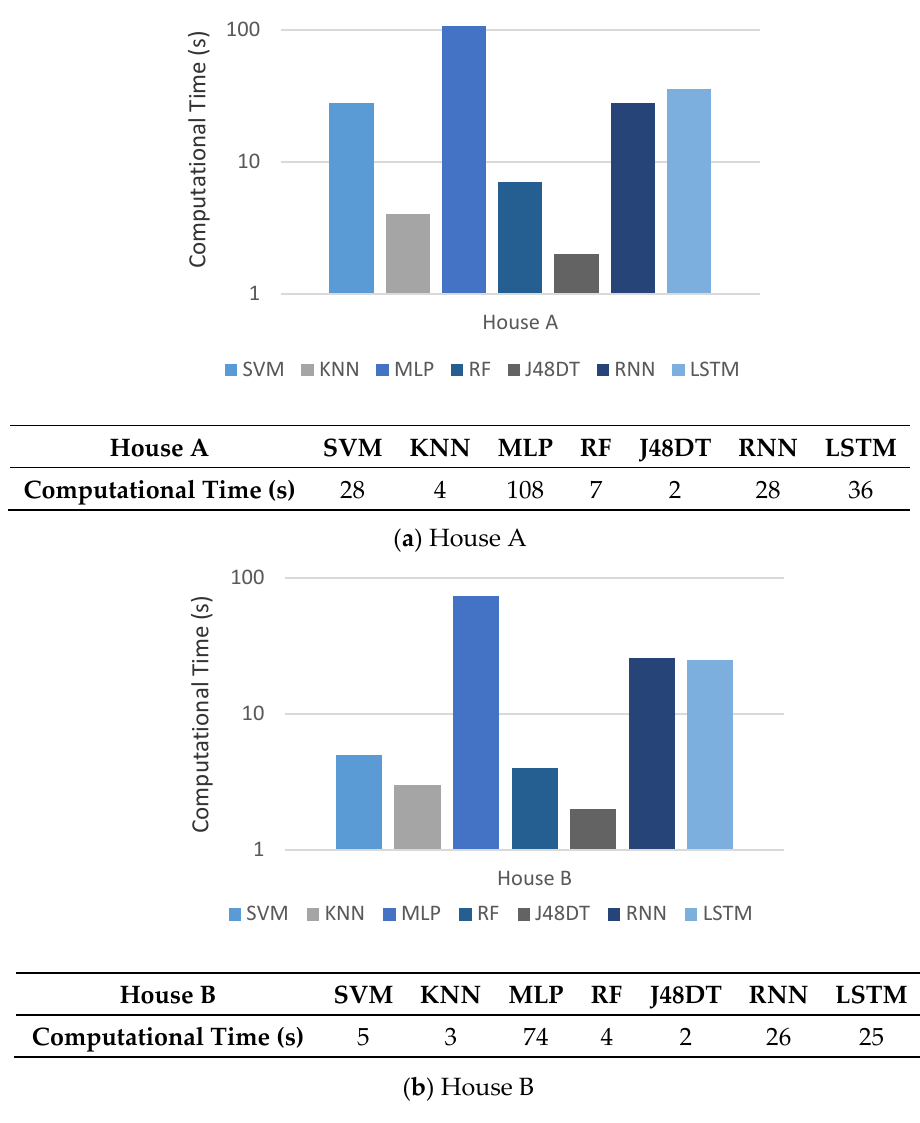
Figure 10. Comparison on computational complexity of different methods.